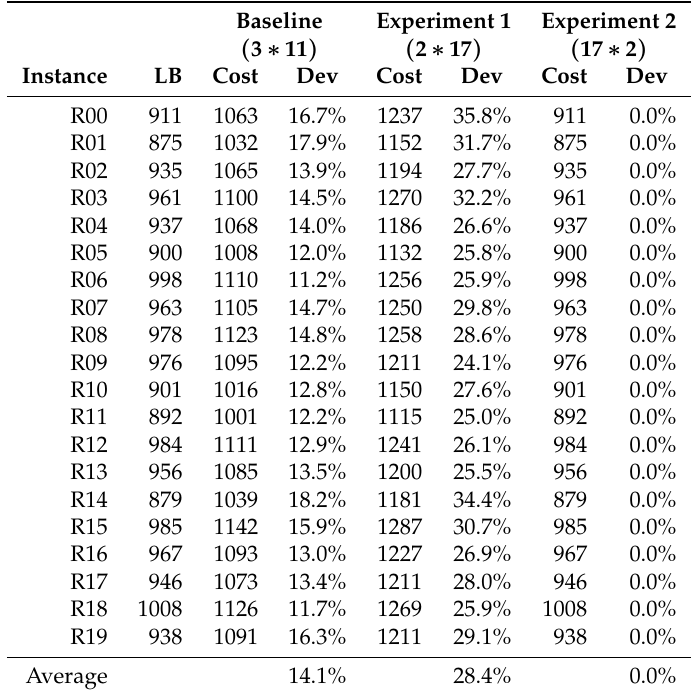
Table 2. Results for instances with 33 customers and three different container configurations, given as ( R ∗ L ) .